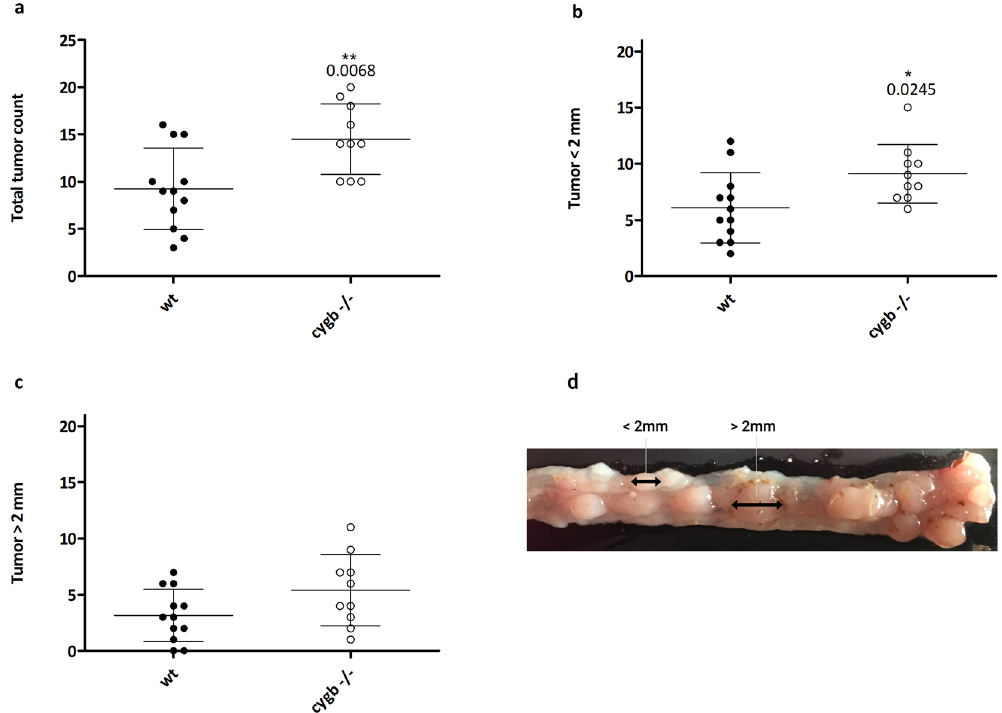
Figure 8. Tumorigenesis in Cygb-deficient mice. ( a ) Comparison of the total numbers of macroscopic tumors in WT (n = 12) and Cygb − / − mice (n = 10). ( b ) Tumors < 2 mm in WT and Cygb − / − mice. ( c ) Tumors > 2 mm in WT and Cygb − / − mice. ( d ) A representative image of distal colonic tumors ( < 2 mm and > 2 mm) from an AOM/DSS-treated mouse colon. Each dot represents an individual mouse. The results are presented as the mean ± SD. Statistical analysis was performed using Student’s t-test, and P values are shown. The experiment was initiated by AOM injection, followed by three cycles of 3% DSS for 7 days/cycle in weeks 2, 5 and 8. All mice were euthanized in week 10, two weeks after the end of the third DSS